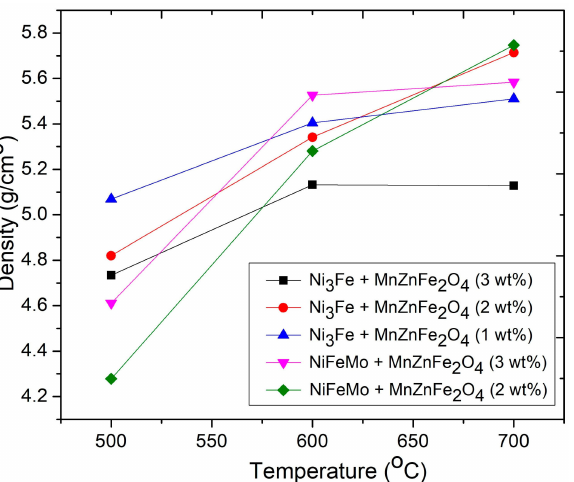
Figure 3. Influence of the amount of ferrite nanoparticles and the sintering temperature on the density of composite compacts obtained by SPS from (N 3 Fe, supermalloy) @Mn 0.5 Zn 0.5 Fe 2 O 4 . Sintering time was 0 min.